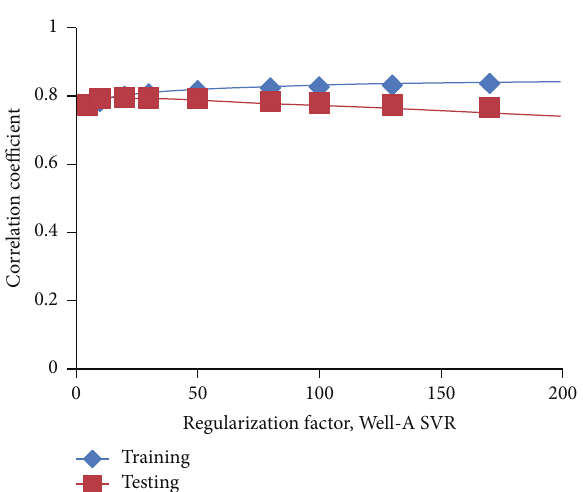
Figure 4: Sensitivity of SVR model to regularization factor (Well-A).